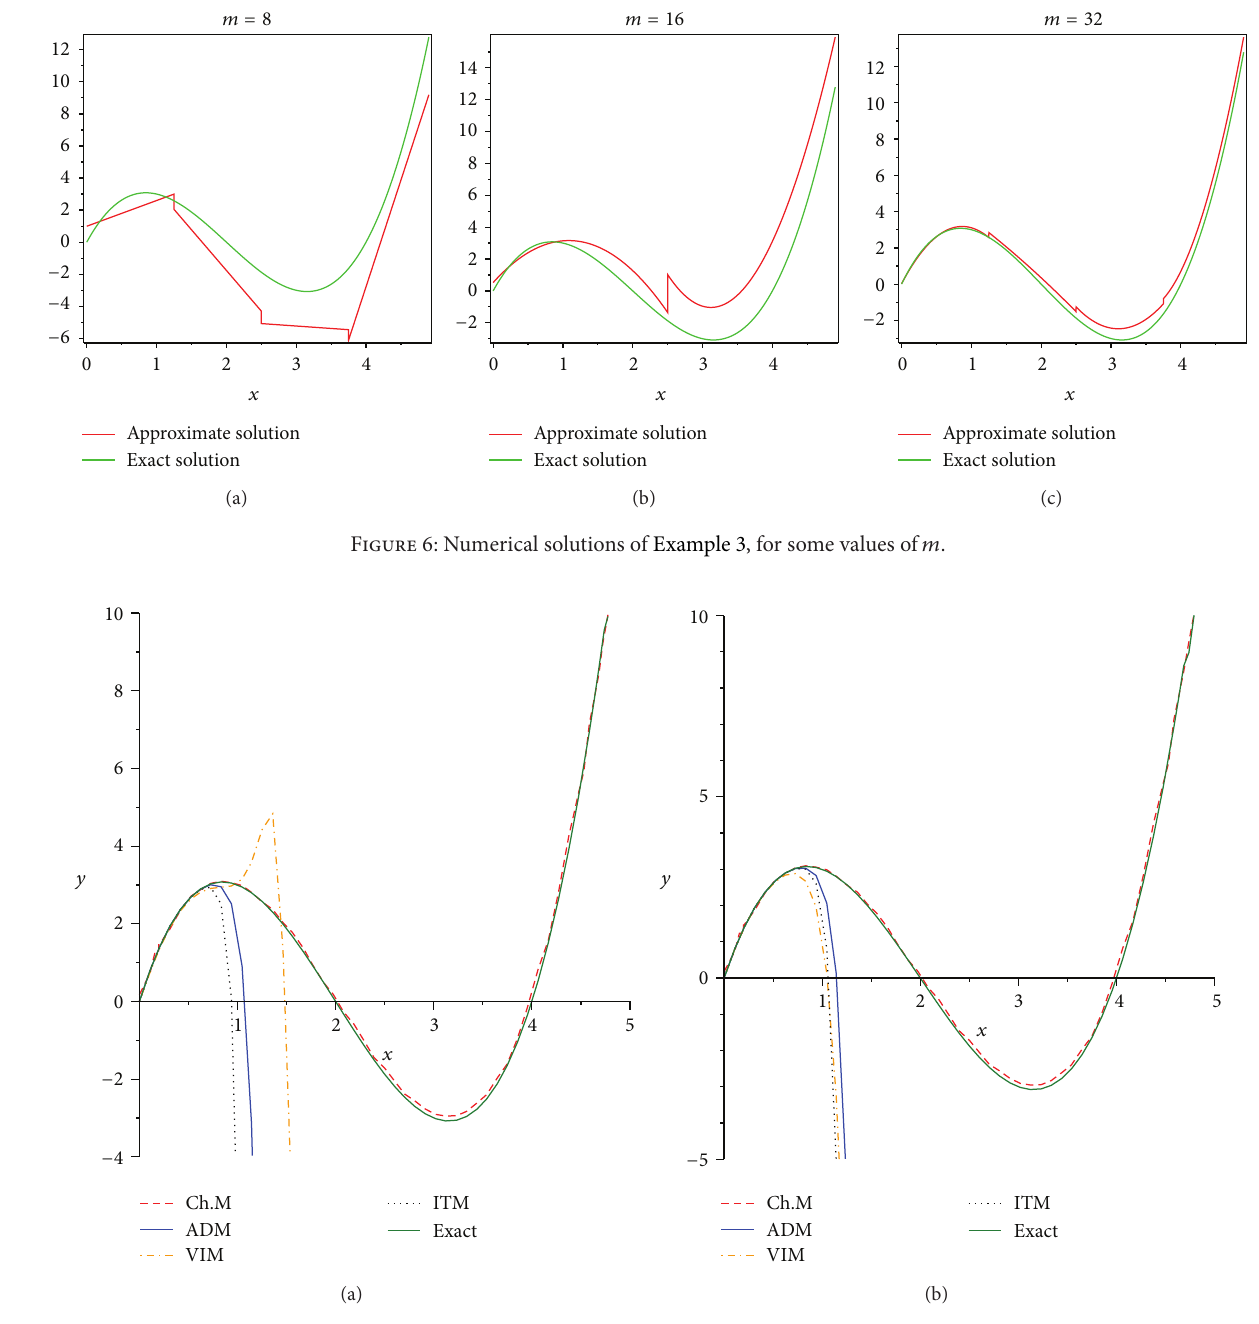
Figure 7: Numerical solutions of Example 3, for 𝛼 = 0.80 (a) and 𝛼 = 0.90